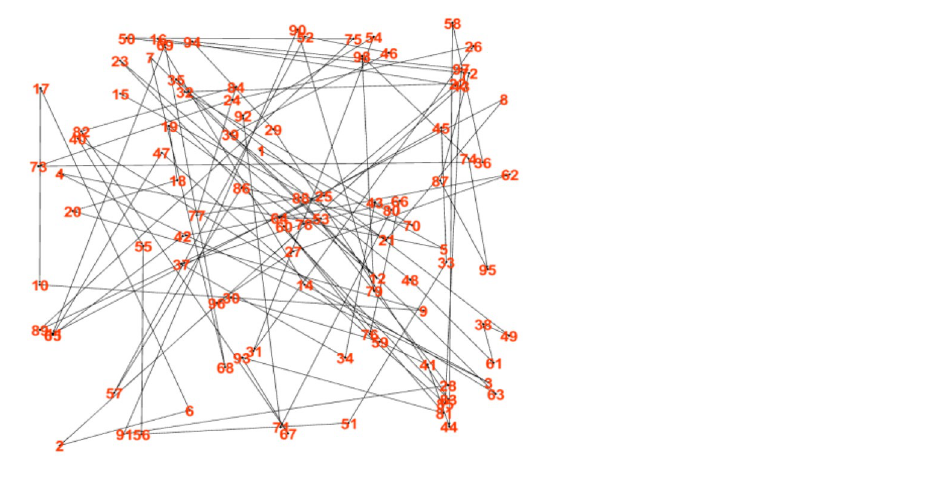
Figure 10. The constructed graph using the contact ability based topology control